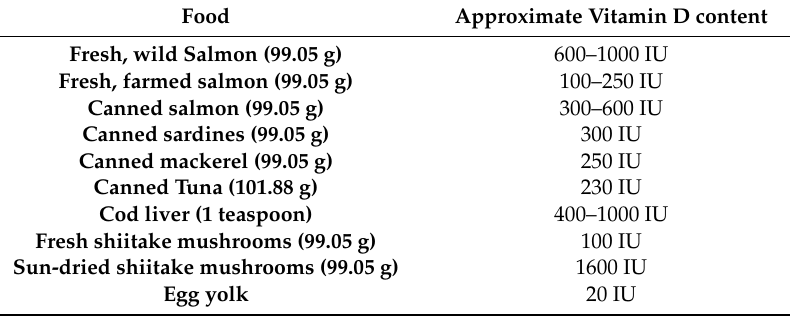
Table 3. Vitamin D content of chosen foods, modified by